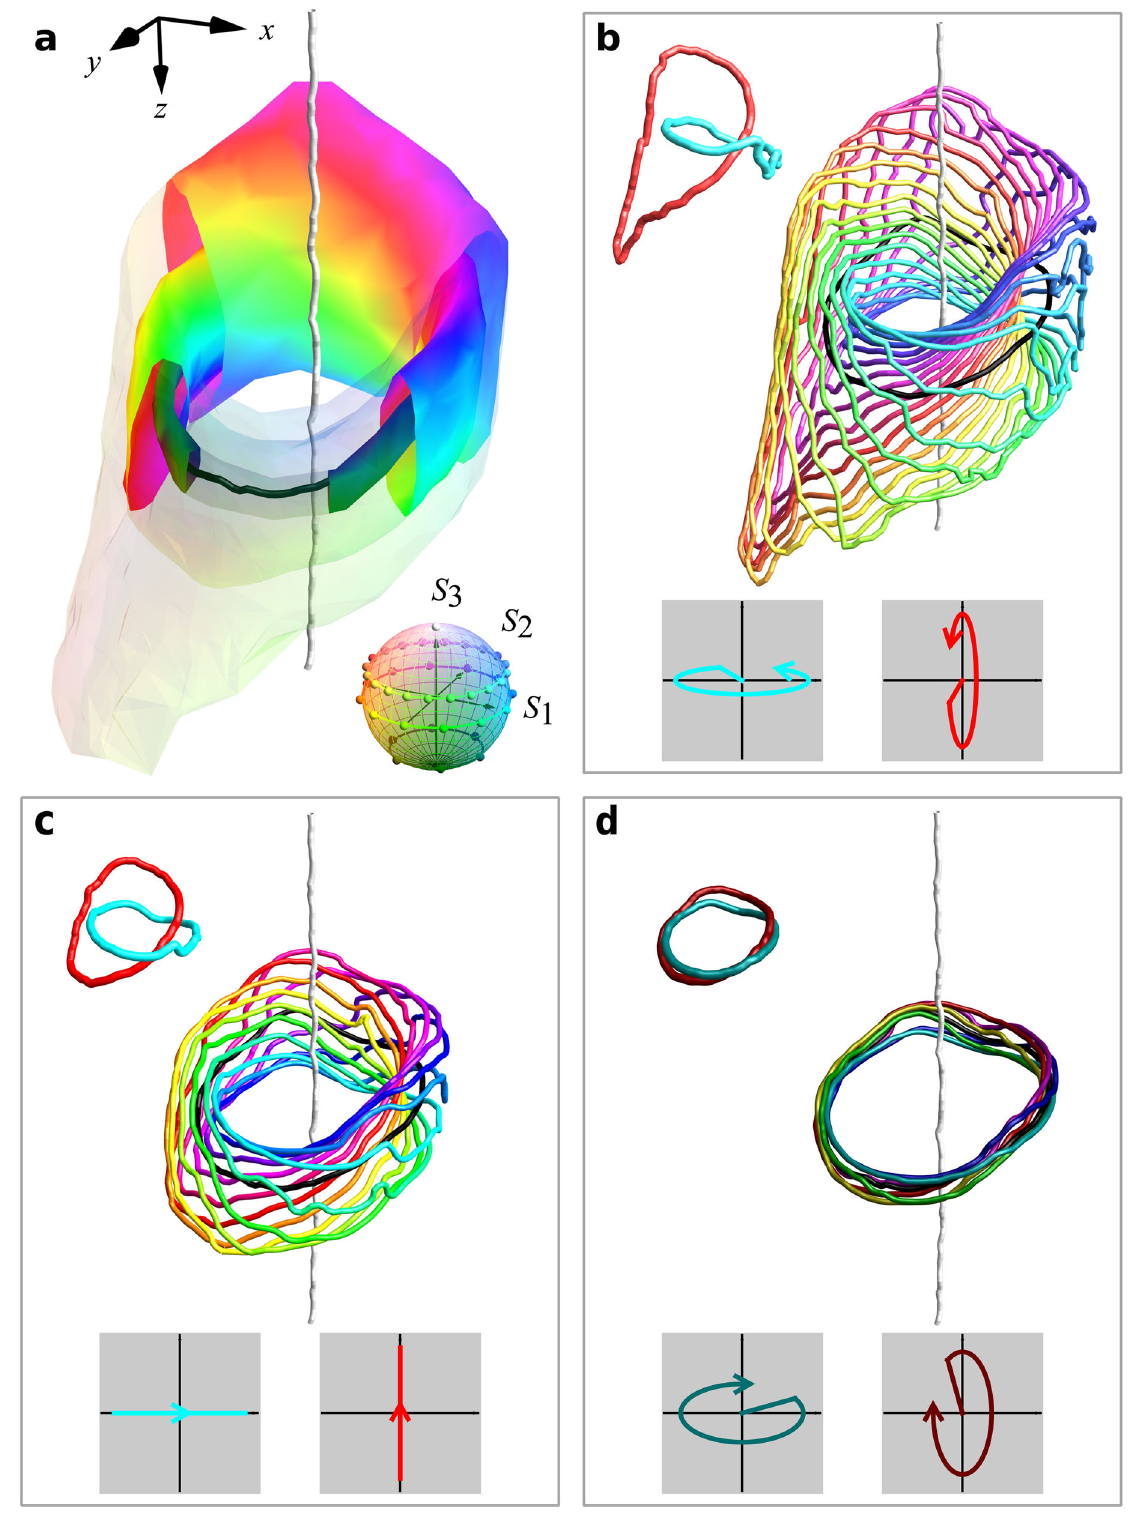
Fig. 3 Visualising the topology of the focal volume. The optical texture is reconstructed from the polarisation and phase measurements via the VFFR of the optical beam. The measured volume is coloured following the Poincaré sphere and reveals the topological structure of the Hopf fi bration ( a ). Two C lines, the black loop and the threading straight white line, organise the texture into nested tori. Each toroidal surface represents points characterised by the same ellipticity. The colours wind nontrivially around each torus, and a few polarisation fi laments making up these tori are shown in the insets: in ( b ), the lighter surface ( S ¼ 0 : 398) is made of lines characterised by RH elliptic polarisation; in ( c ), the L surface ( S ¼ 0) is made of lines along which the 3 3 polarisation state is linear 23,26 ; in ( d ), the darker surface ( S 3 ¼ (cid:2) 0 : 775) is made of lines characterised by LH elliptic polarisation. In each inset, the cyan and red fi laments, corresponding to β ¼ 0 ; π are shown to form a Hopf link. Every pair of fi laments in the texture link in this way, consistent with the Hopf fi bration. The 3D rendering of this experimental skyrmionic hop fi on is in the Supplementary